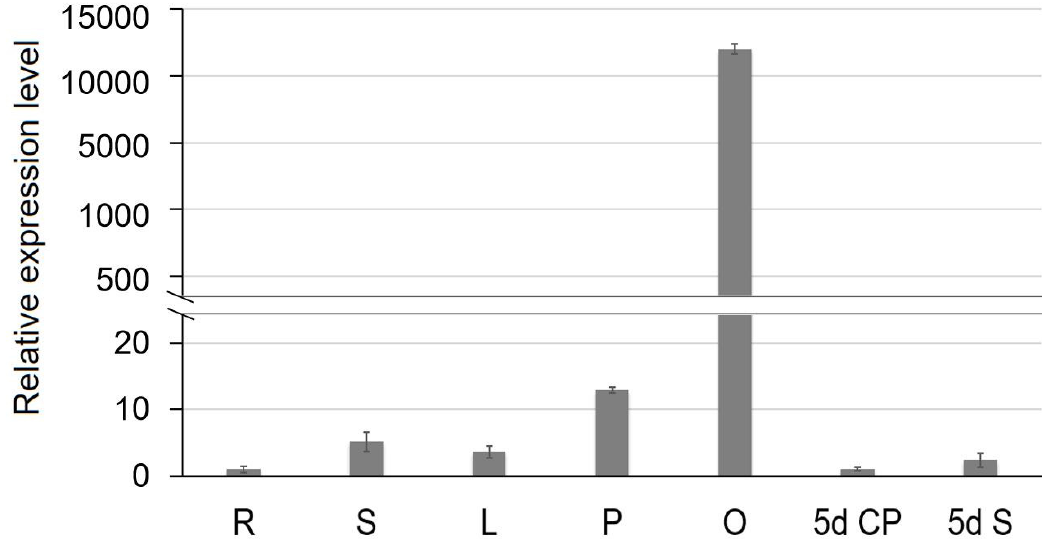
Figure 6. Expression analysis of SiCS1 in different tissues of Yuzhi 11 by qRT-PCR. R root, S stem, L leaf, P petals with stamens, O ovary at the flowering day, 5d CP 5 days capsule peel after flowering, 5d S 5 days developing seeds after flowering.